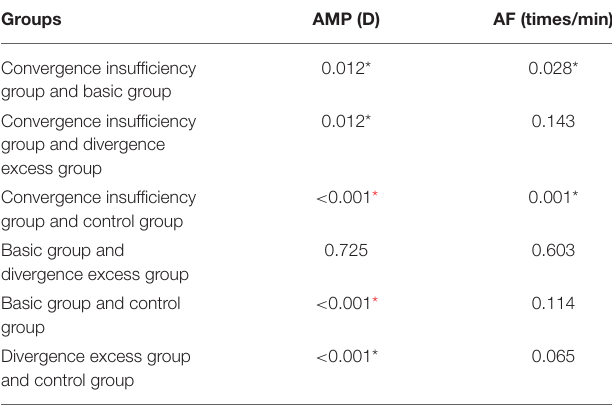
TABLE 5 | Pairwise comparison of binocular AMP and AF among four groups.